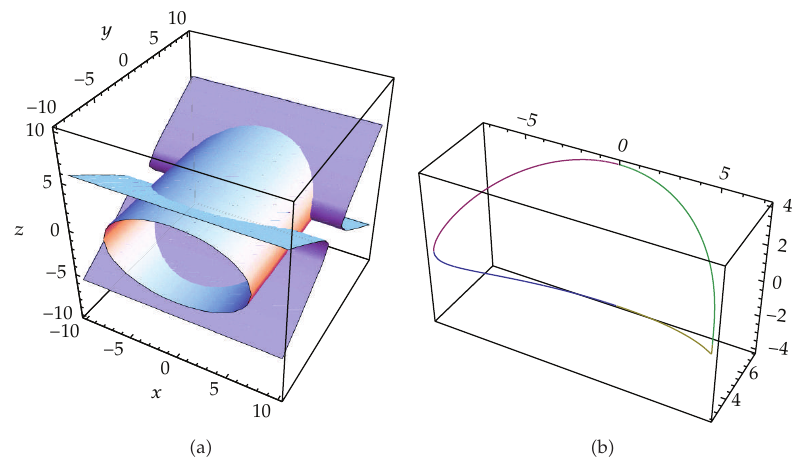
Figure 1: The phase curves of the system (cid:2) 2.11 (cid:5)